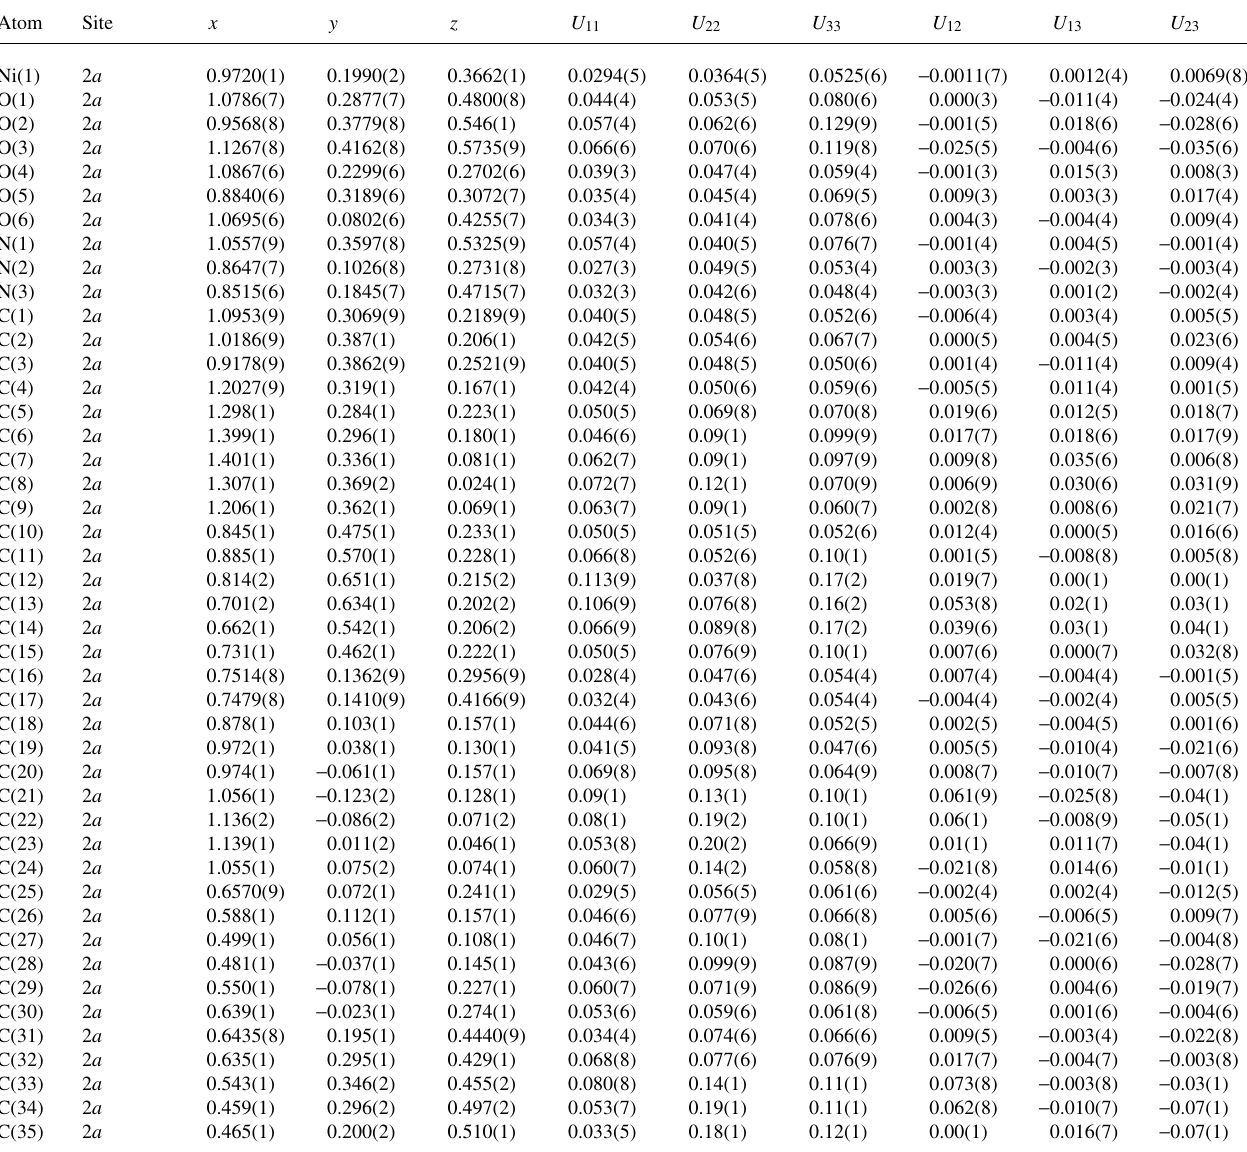
Table 3. Atomic coordinates and displacement parameters (in Å 2 )